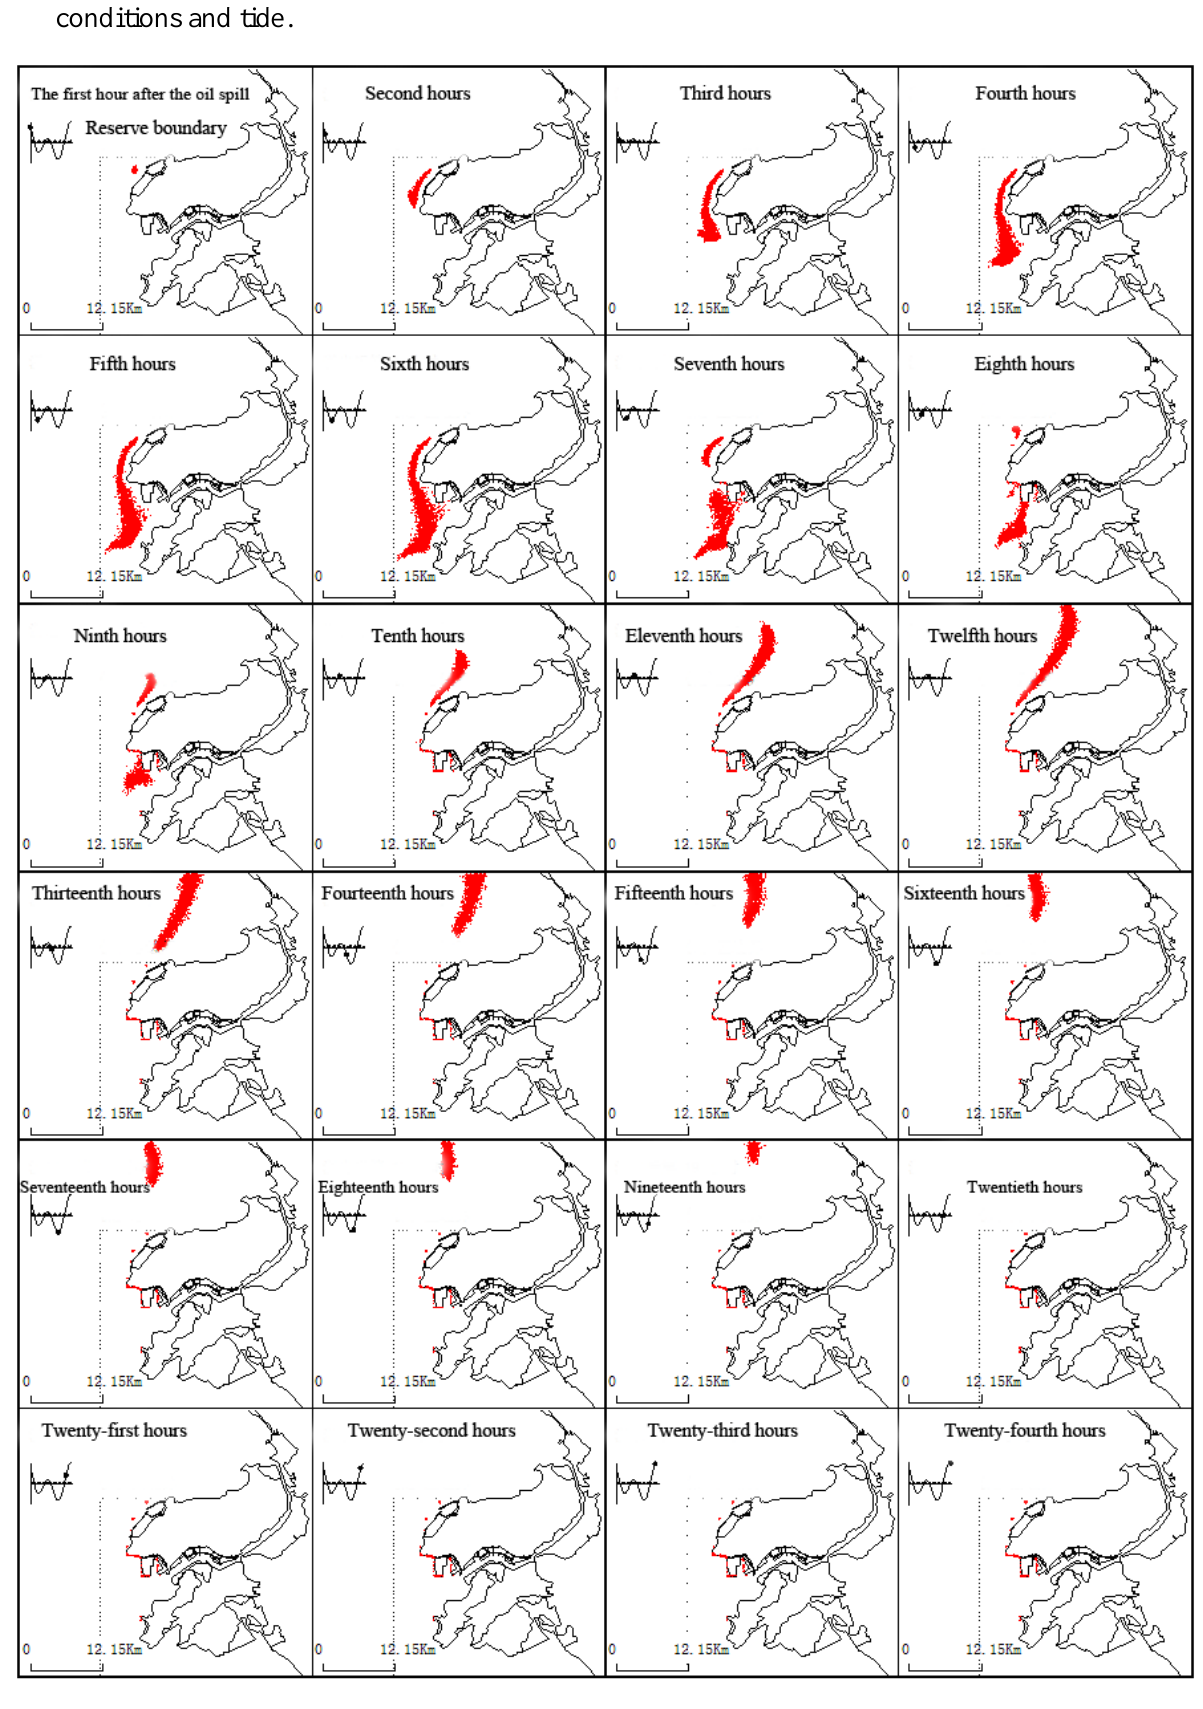
Figure 3. The dynamic changes of the oil film under continuous drift and SSW wind conditions and